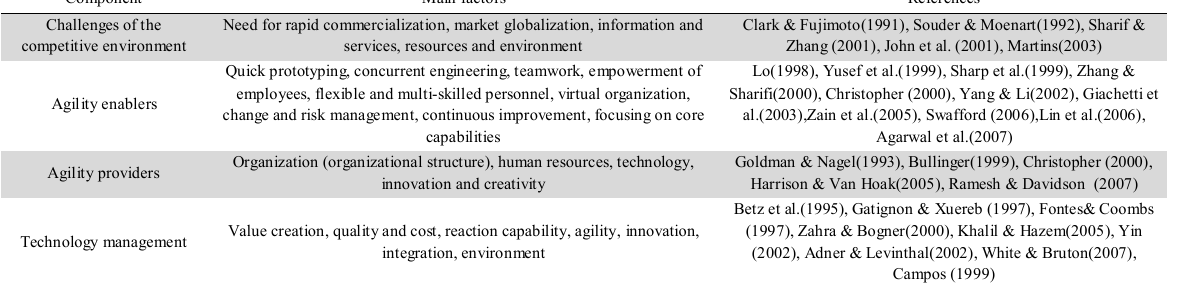
Main components and factors for developing the proposed W-model